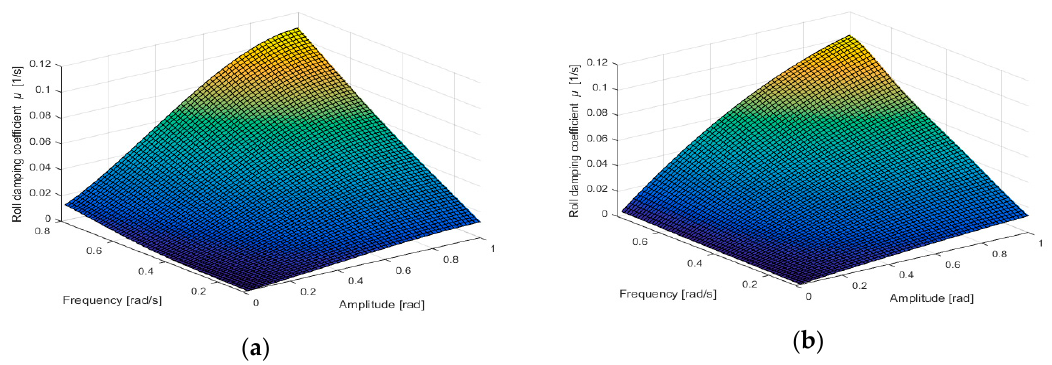
Figure 4. Damping coefficients for the offshore support vessel ( T = 6.10 m, GM 0 = 2.50 m, C B = 0.778, C M = 0.987, bilge keel: l BK = 19.00 m, b BK = 0.30 m) calculated according to the simple Ikeda’s method ( a ) and next approximated using coefficients α ( ω ), β ( ω ) and γ ( ω ) in Equation (11) ( b ).